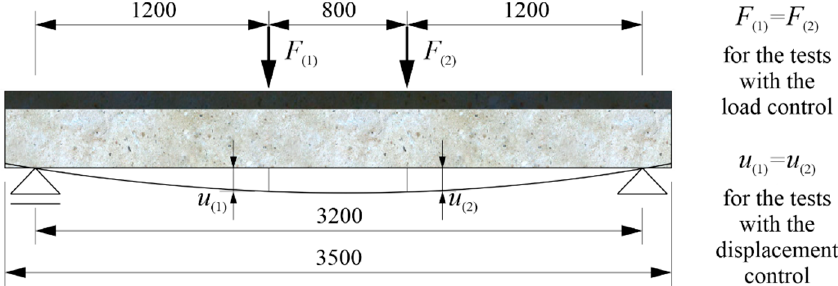
Figure 8. Static scheme of the beams’ loading ( F ( 1 ) , F ( 2 ) —loads from the actuators; u ( 1 ) , u ( 2 ) —deflection under the actuators; dimensions in mm).